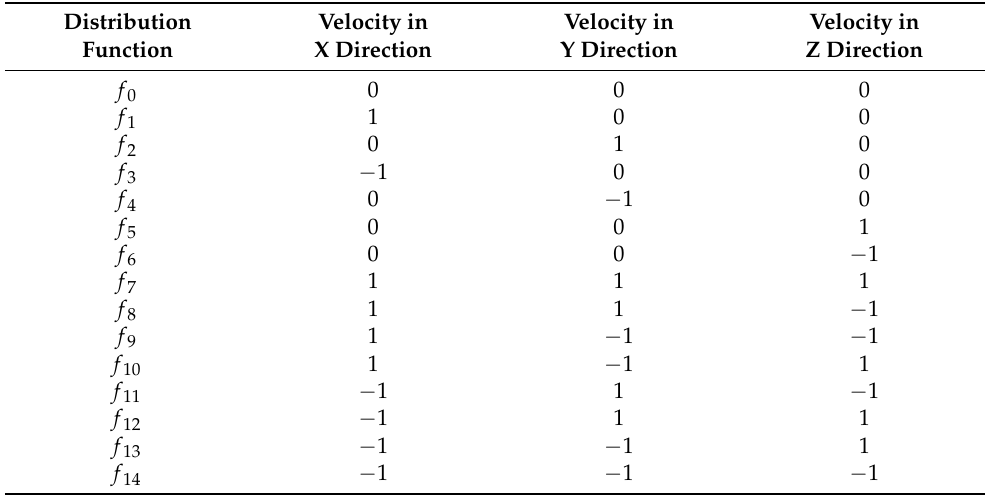
Table 1. Velocity vectors for